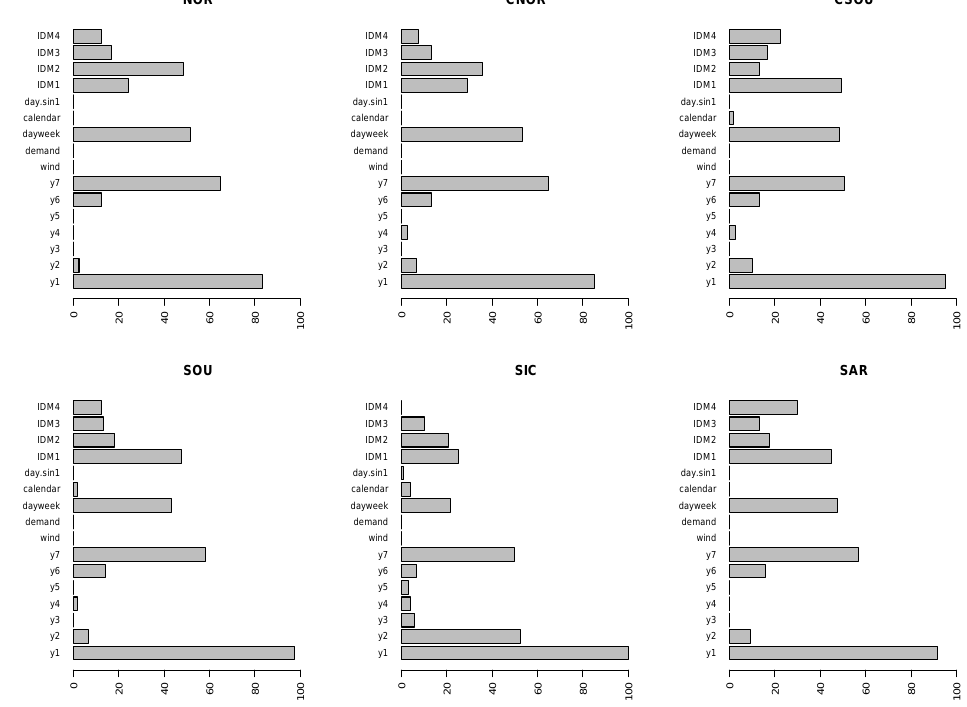
Figure 7. Variable importance measures for the SVM. Weighted percentage of times the variables are within the fifth position out of 24